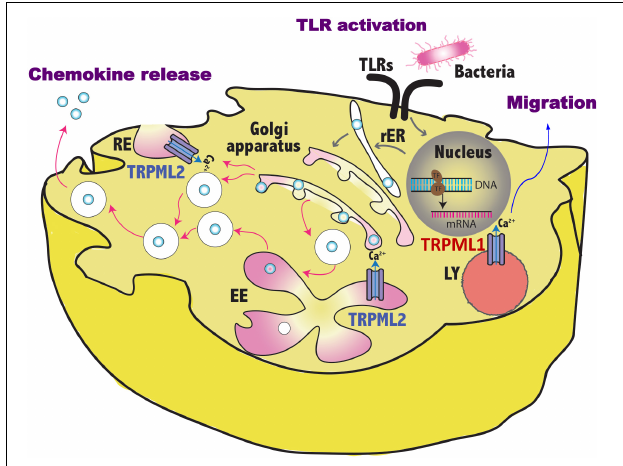
FIGURE 1 | Schematic representation of TRPML1 and TRPML2 involvement in the regulation of vesicles trafficking induced by pathogen sensing. By controlling the fluxes of vesicular Ca 2 + , TRPML1 promotes in dendritic cells the activation of myosin II that leads to fast and directional migration whereas TRPML2 regulates in macrophages the fission/fusion processes of transport vesicles and so the release of chemokines in the environment. TLR, toll like receptor; RE, recycling endosome, LY, lysosome; EE, early endosome; rER, rough endoplasmic